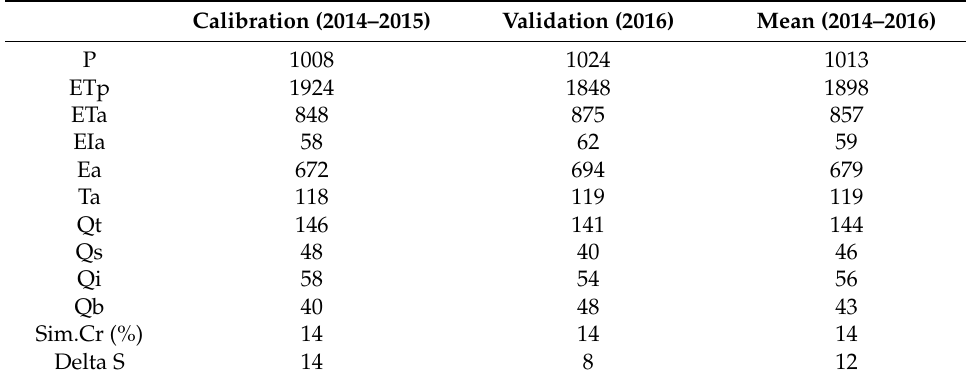
Table 7. Water balance components in mm per year of the Mebar model for the calibration and validation